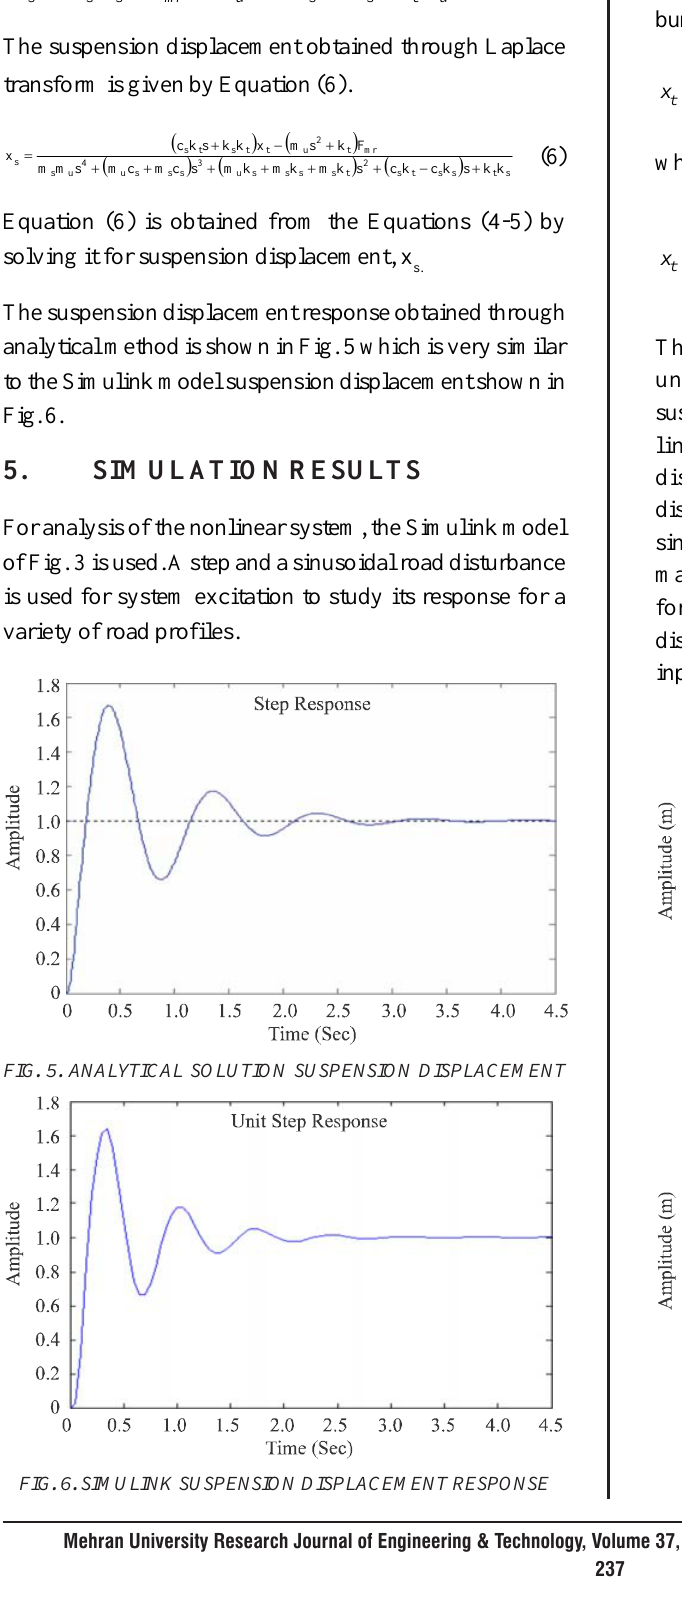
FIG. 8. SINUSOIDAL